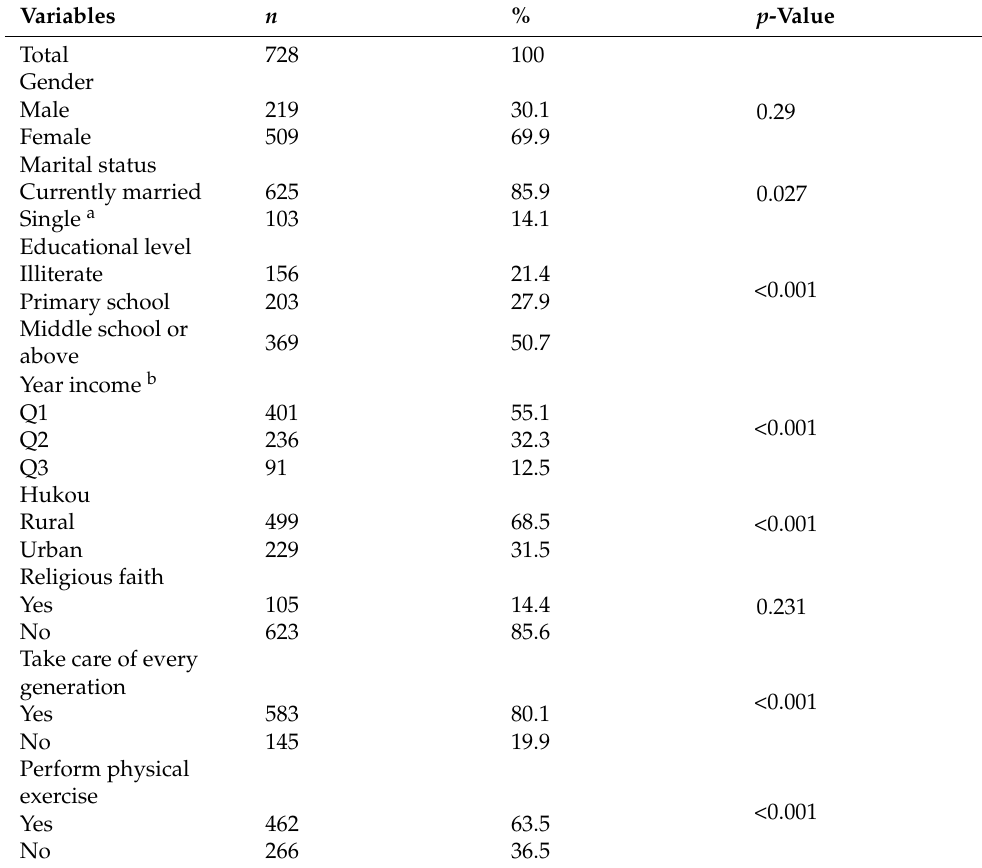
Table 1. Demographic characteristics of the participants ( n =